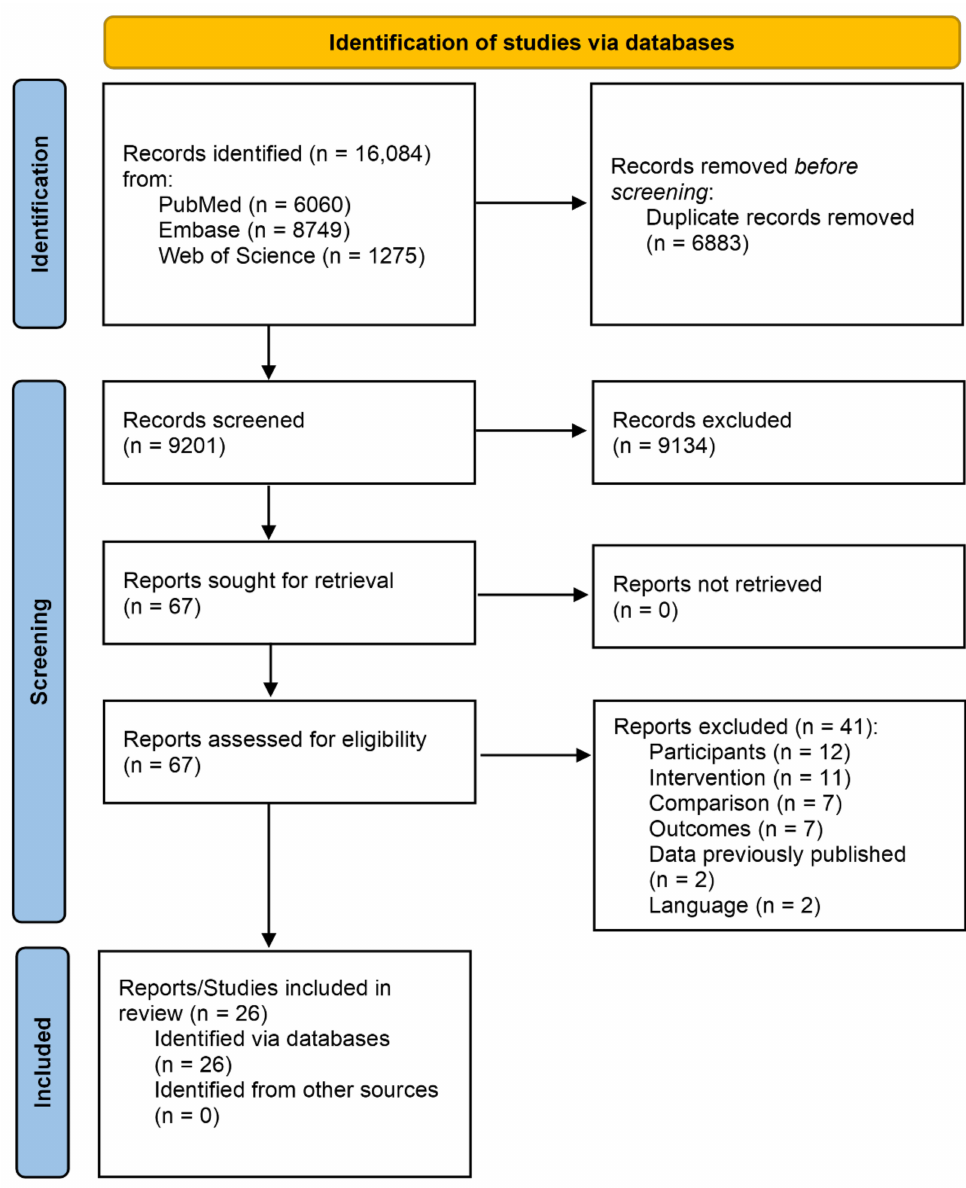
Figure 1. Flowchart ANS activity in sedentary